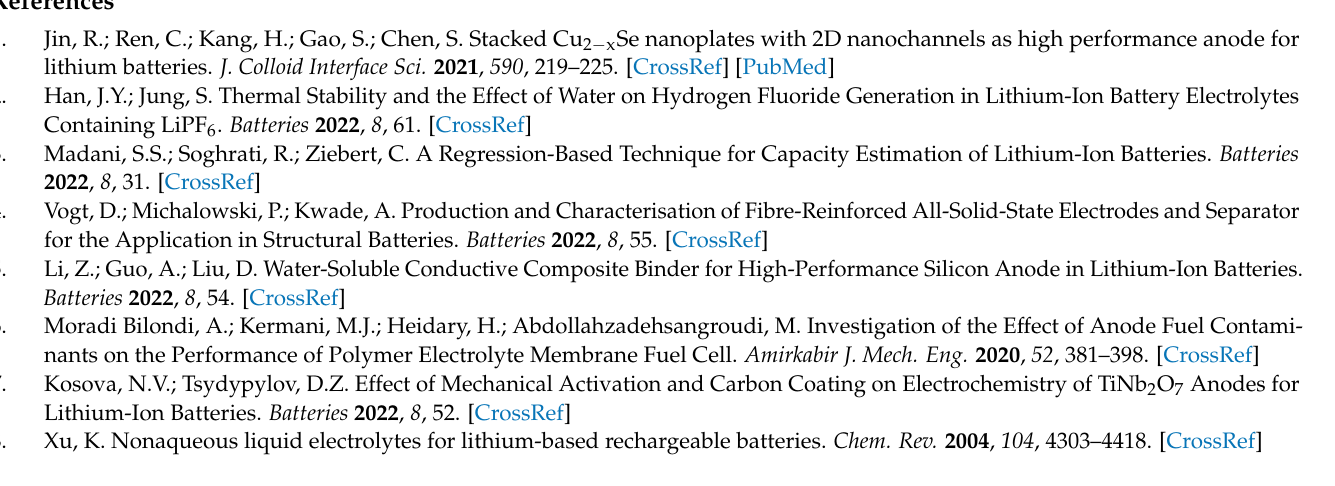
graphite surface. Figure S3: First charge-discharge profiles of Li/graphite half-cells using reference electrolyte with no and with various amounts of PMS. The cells were cycled between 0.001–3 V at 0.1 C. Figure S4: Nyquist plots of Li/G half-cells (a,b) without and with 2% PMS after 5 cycles 0.5 C as the formation and after 50 cycles 1 C, respectively, (c,d) without and with 3% PMS after 5 cycles 0.5 C as the formation and after 50 cycles 1 C, respectively. Figure S5: EDS patterns of the graphite electrode after cycling; (a) in the reference electrolyte; (b) in the reference electrolyte with 1 wt% PMS. Table S1: Parameters of the first charge-discharge of Li/graphite half-cells containing various amounts of PMS. Table S2: The computed frequencies of PMS molecule in the frequency range of 1200–1600 cm -1 and mode assignments. Scheme S1: The Born-Haber cycle for calculation of oxidation potential. Scheme S2: The Born-Haber cycle for calculation of reduction